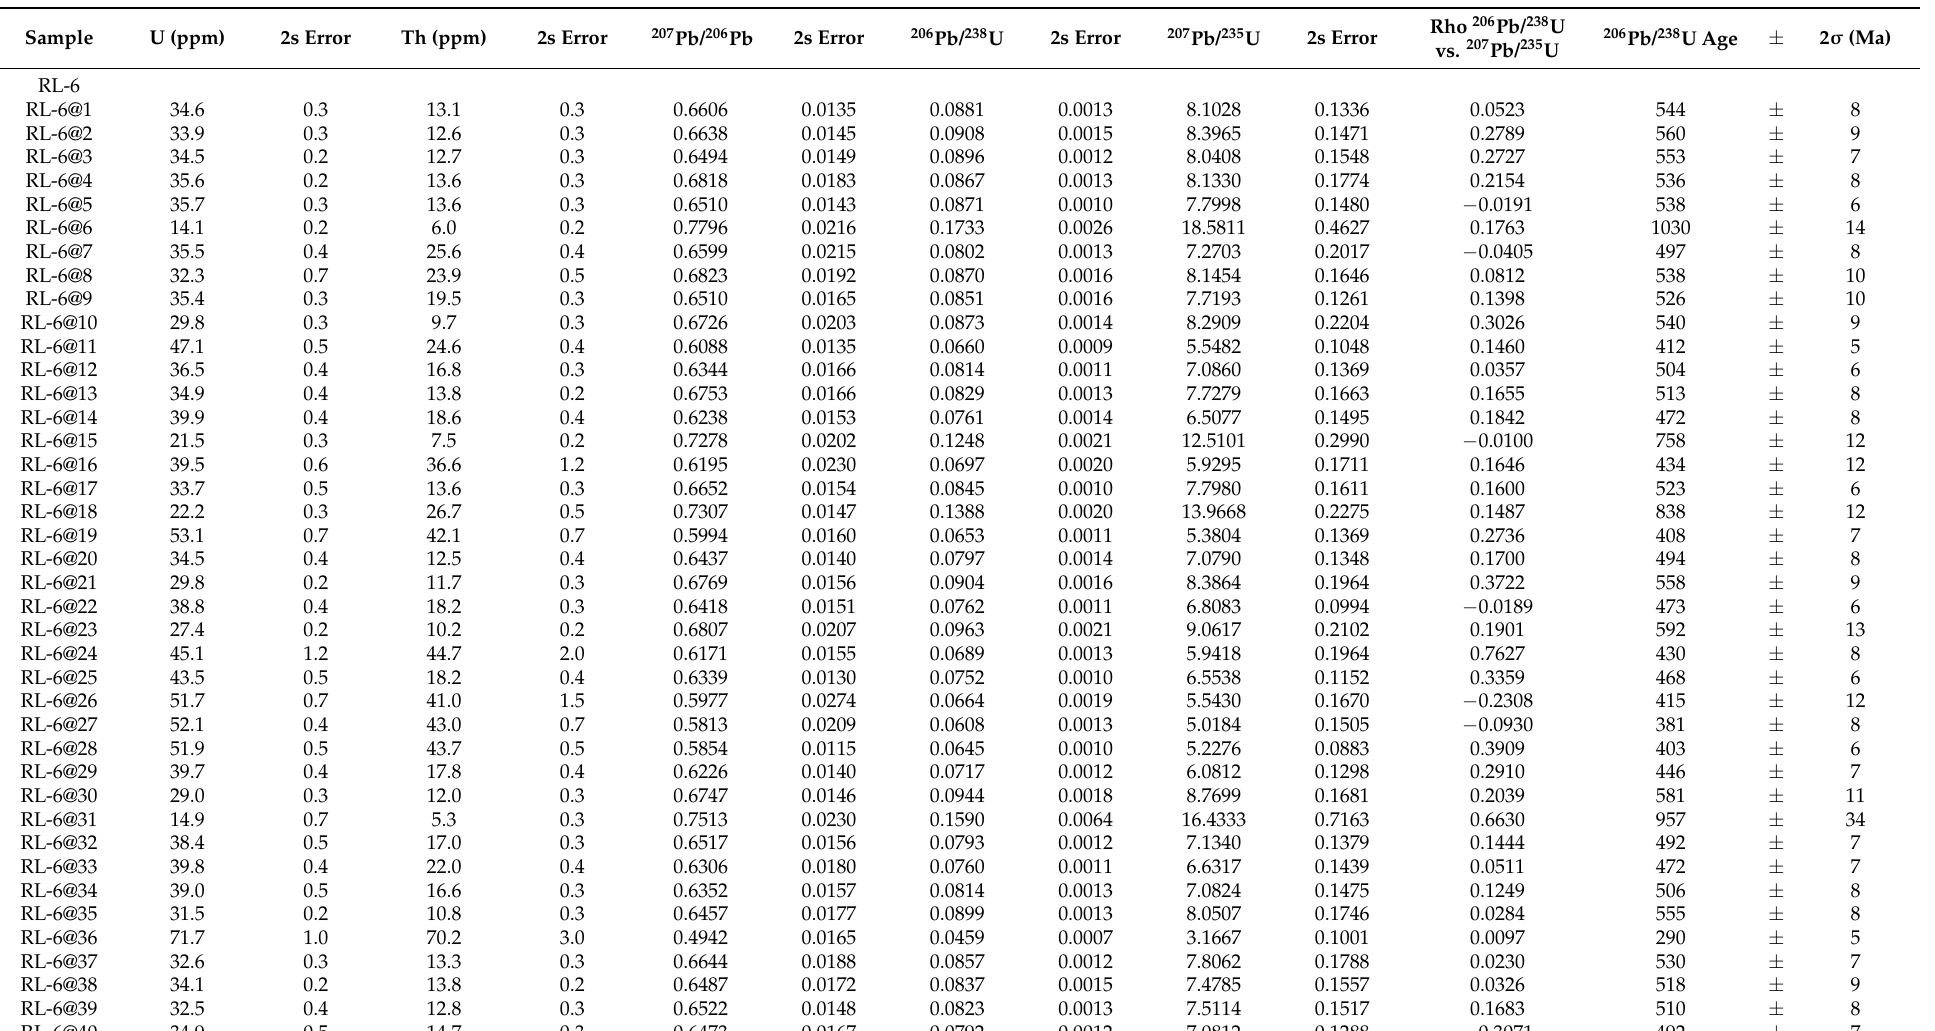
Table 5. Apatite U-Pb dating by